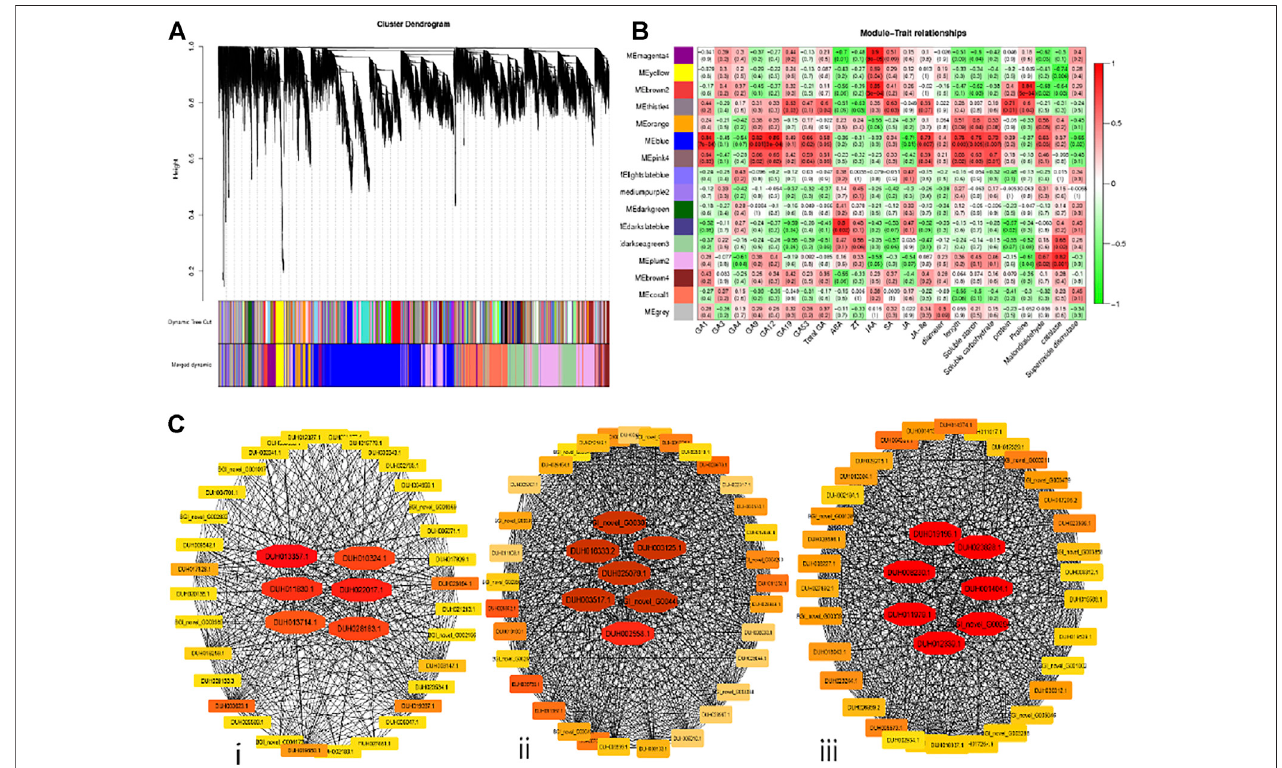
FIGURE 7 | WGCNA has driven eigengenes-based gene networks related to the regulation of fl oral bud dormancy in R . delavayi Franch. (A) Clustering via a hierarchicalapproachreveals16resultingmodulesharboringco-expressedweightedgenes.Eachgeneinthemodulescorrespondstoaseparateindividuallea fl etofthe cluster tree. (B) Association chart between traits and modules utilizing Pearson correlation coef fi cient ranging between − 1 to 1with green to red gradient. (C) Interaction network for the three eigengenes/hub genes modules related to phenotypic, morphological, and biochemical traits scored to get information related to the regulation of bud dormancy in R . delavayi . The candidates ’ eigengenes/hub genes localized in the depicted networks for (i) blue, (ii) pink4 and (iii) thistle4 modules are tinted with red due to their higher weights than other genes in the orange to yellow